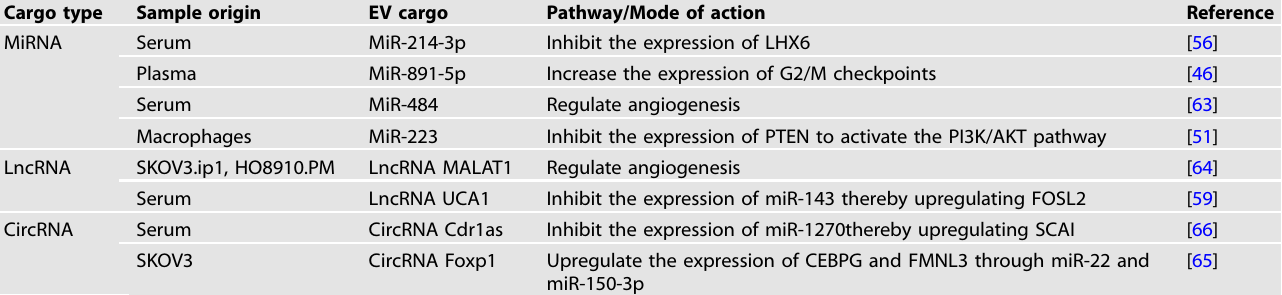
Table 2. EV noncoding RNA biomarkers proposed for monitoring OC chemoresistance.